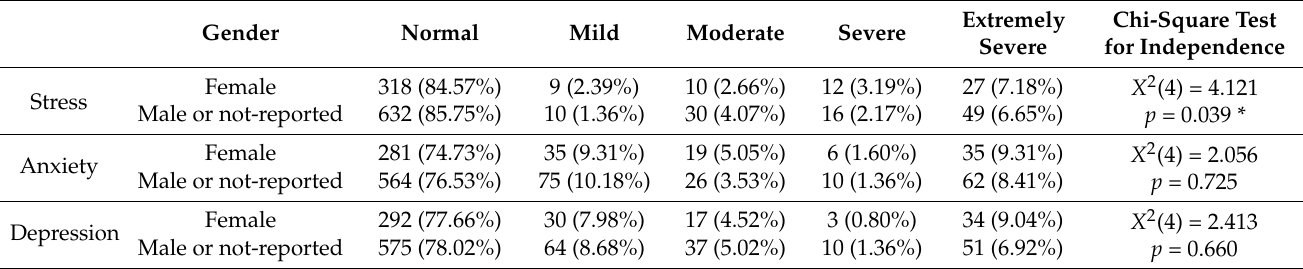
Table 3. Self-reported stress, anxiety and depression levels by gender groups, n